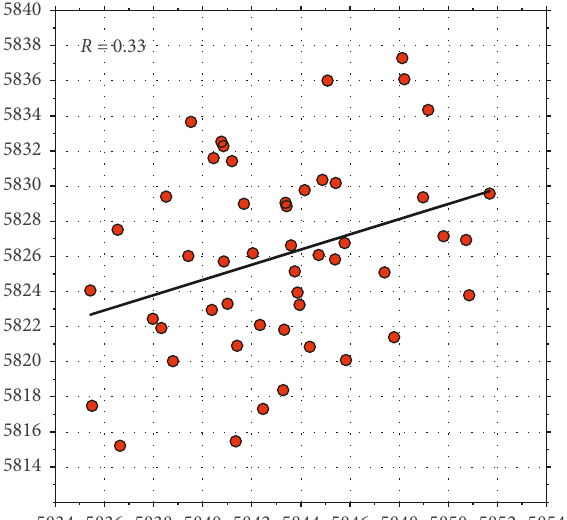
Figure 9: Scatter plot (red plots) of area-averaged 500 hPa GPH over SCB on 18 July (forecast for next 90–108 h, 4-time average, y - coordinate) vs averaged 500 hPa GPH over SCB on 0000 UTC 16 July (forecast for next 48 h, x -coordinate) in the 50 ensemble members after the initial time. The linear least squares fitting line is also shown. The linear correlation coefficient is given in the top left.